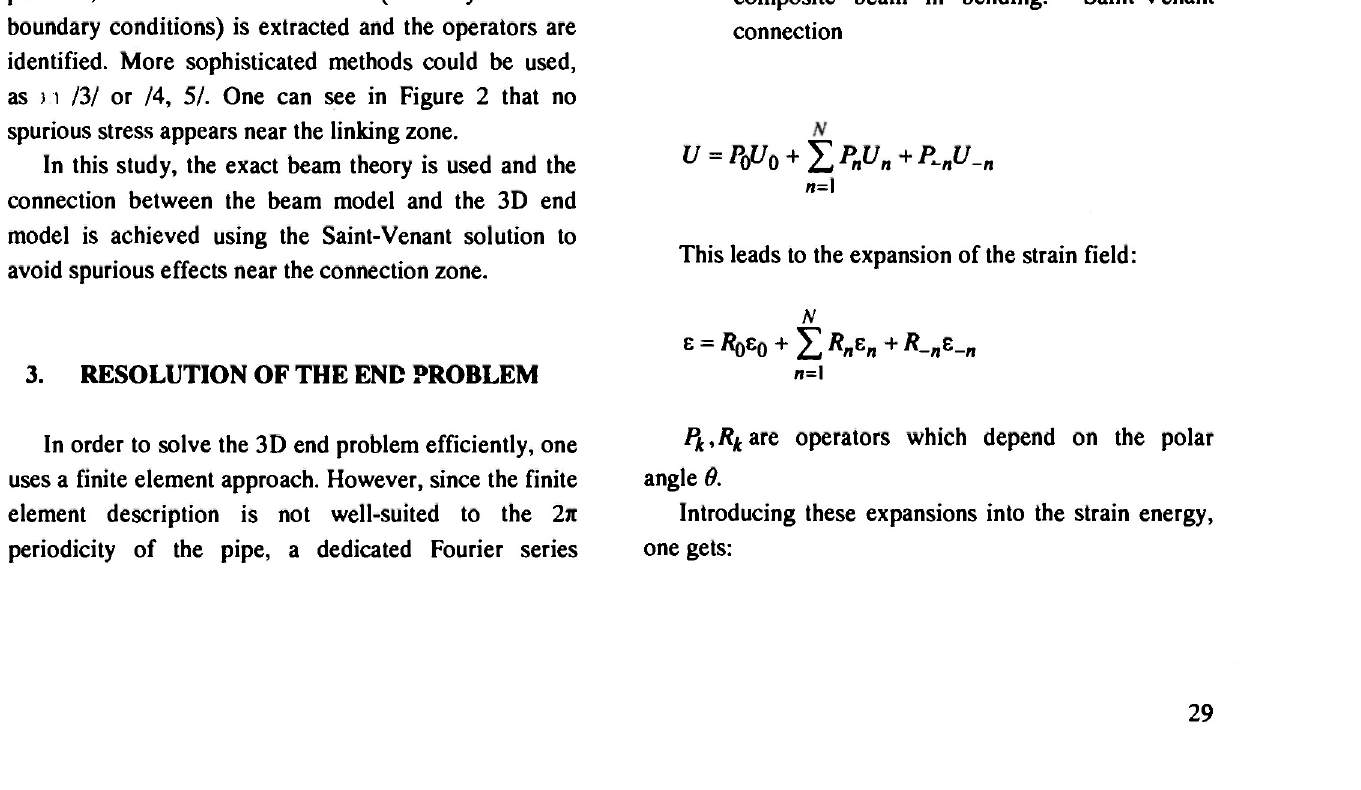
Fig. 2: Evolution of the radial stress (in MPa) with the position along the beam (in mm) for a [0/90/Ö] composite beam in bending: Saint-Venant